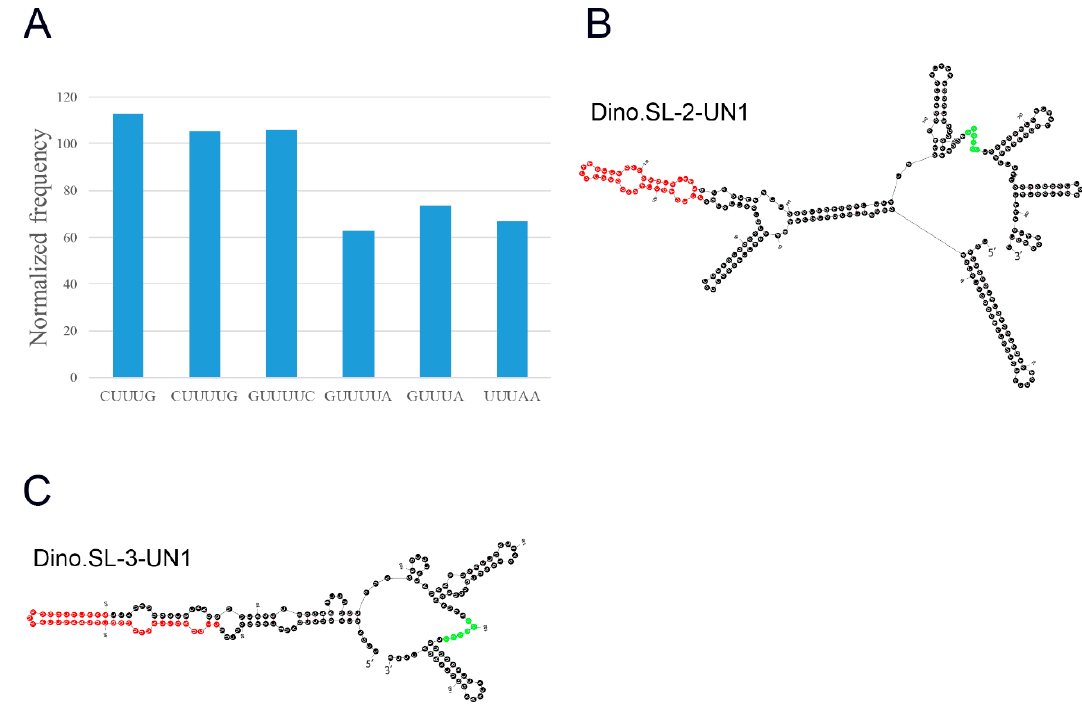
Figure 3. Potential Sm-protein binding sites. ( A ) The appearances of U-rich motifs in introns of F. kawagutii genes; the secondary structure of SL genes, ( B ) Dino.SL-2-UN1, ( C ) Dino.SL-3-UN1. The proposed Sm-protein sites (GUUUUC) were colored in green and the sequences of SL were colored in red in ( B , C ). The sequences of these SL genes can be found in the Supplementary Table 1.